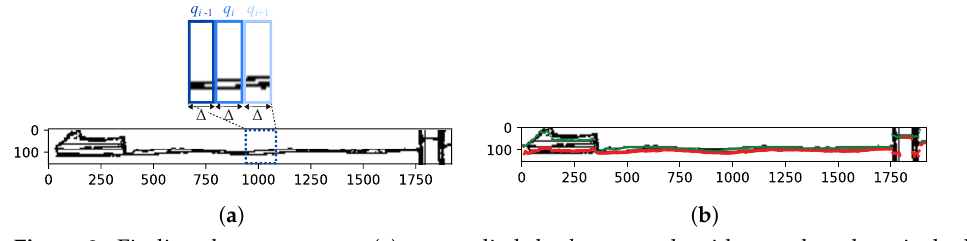
Figure 2. Finding the wave arms: ( a ) we applied the k -means algorithm to the edge pixels that were included in each partition q i of the ROI’s bounding box and the partitions each had a width of ∆ pixels; ( b ) the detected wave arms.